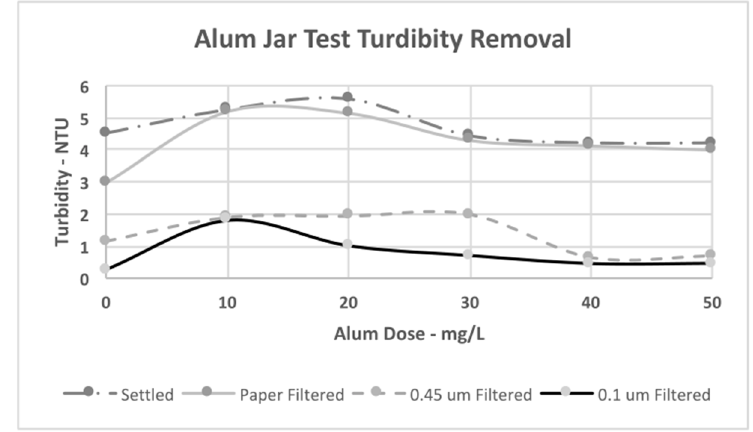
Figure 4. Turbidity after settling versus alum dose and filtering through 8 μ m filter paper, a 0.45 μ m membrane filter, and a 0.1 μ m membrane filter.